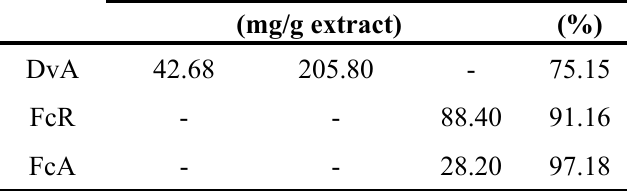
Table 5. Content of inuviscolide, tomentosin and ferulenol in plant extracts. Compounds inuviscolide tomentosin ferulenol others Extract (mg/g extract) (%) DvA 42.68 205.80 75.15 FcR - - 88.40 91.16 FcA - - 28.20 97.18